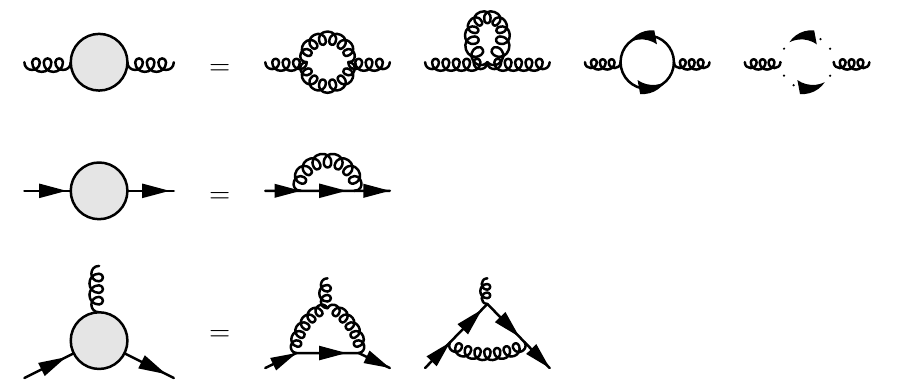
Figure 4 . One-loop diagrams needed for the renormalization of the (cid:12)elds and the coupling. be traced back to higher powers of the anticommutator f (cid:13)